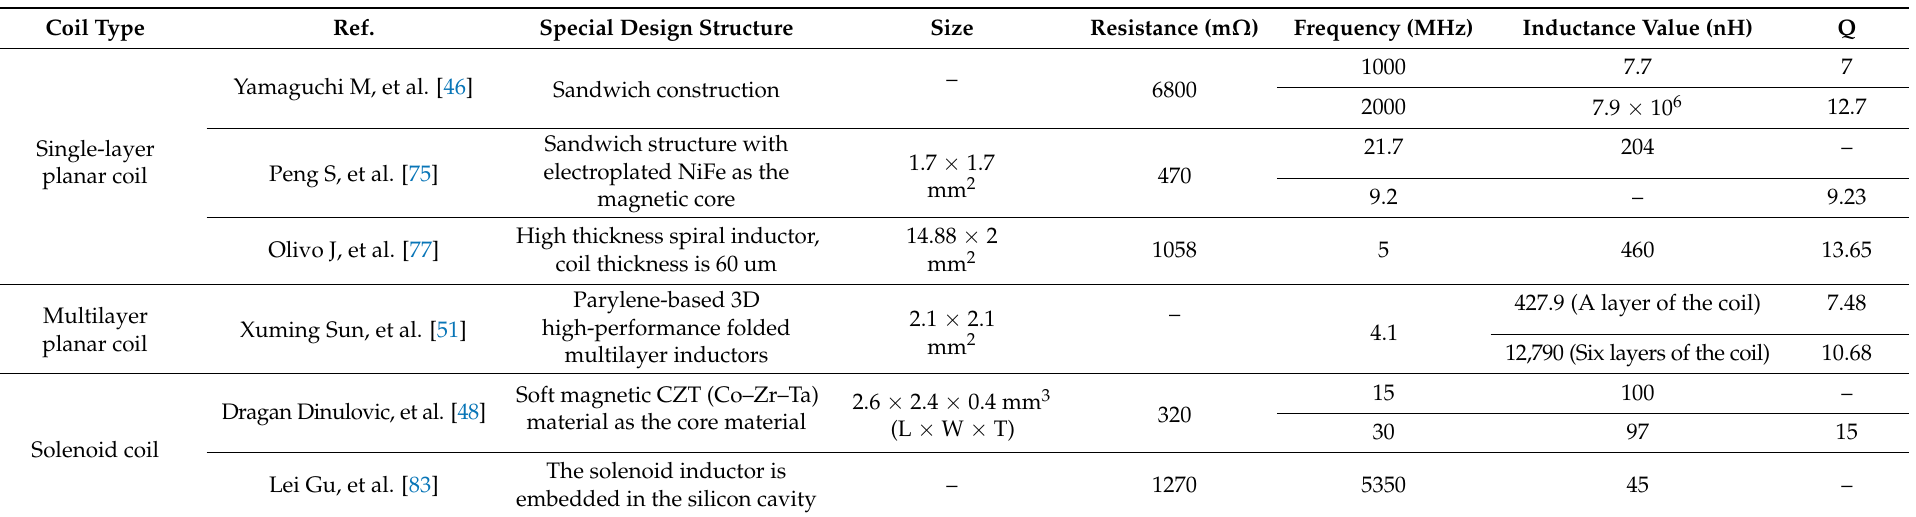
Table 2. Metal coils with different structures based on MEMS processing